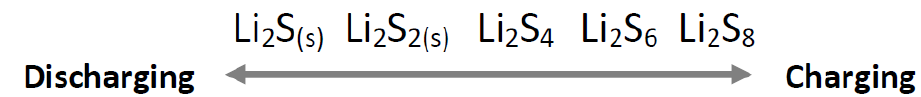
Figure 7. Lithium polysulfides in LSBs during charge/discharge cycle.